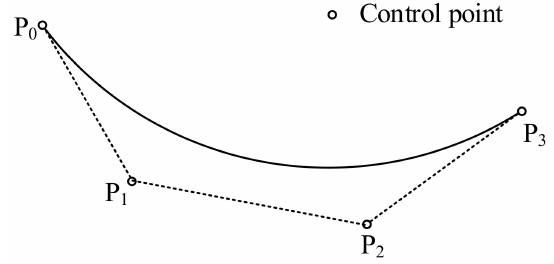
Figure 1. Cubic Bezier curve and its control